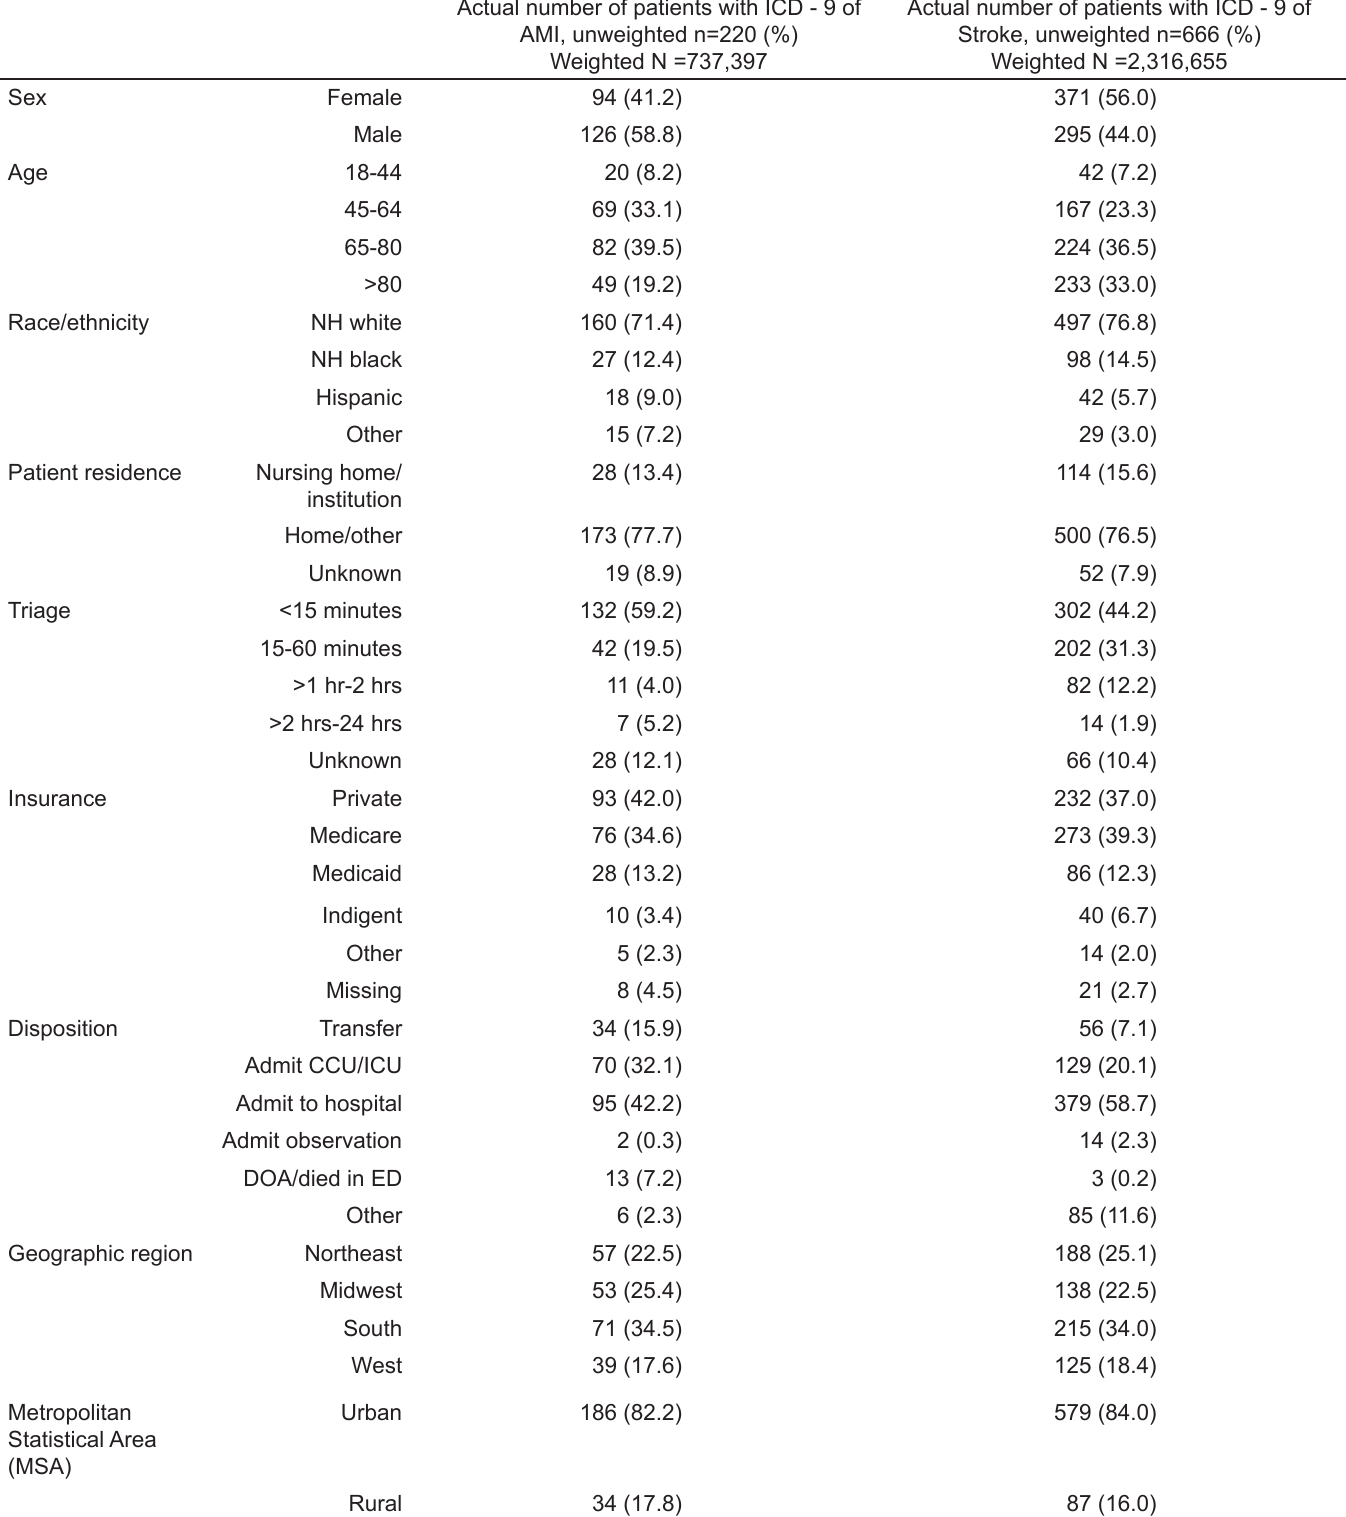
Table 1. Patient characteristics associated with emergency medical services arrival in acute myocardial infarction (AMI) and stroke